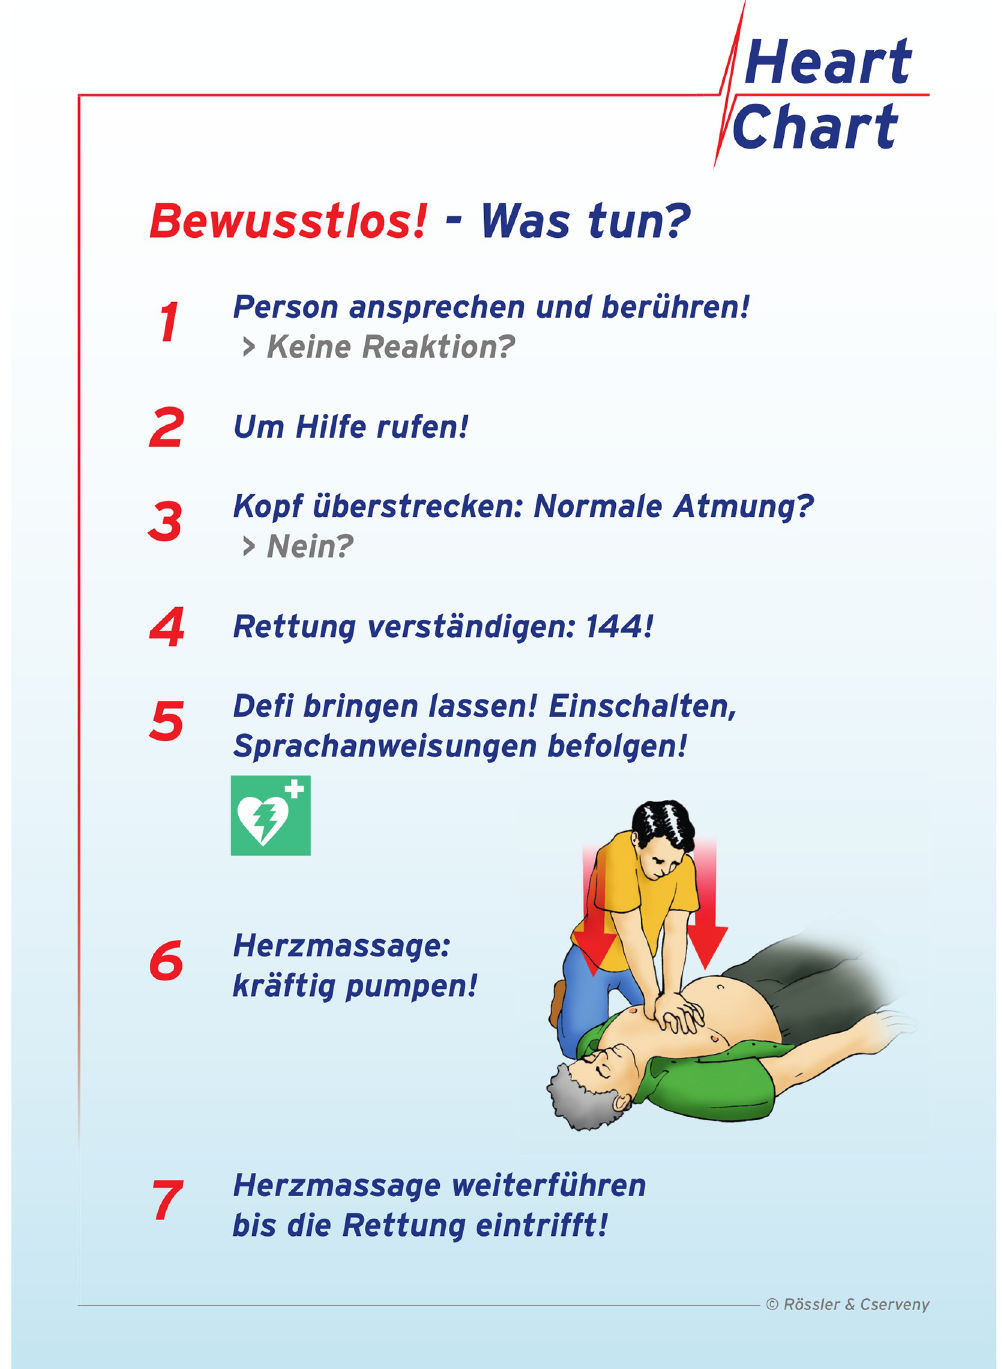
Fig 2. Flowchart of CC-only. Unconscious!—What to do? 1. Speak to and touch the collapsed person! No reaction? 2. Shout for help! 3. Open airway: Breathing?—No? 4. Dial emergency medical service: 144! 5. Send for an Automated External Defibrillator: Activate and follow voice instructions! 6. Chest compressions: Push hard in the middle of the chest. Continue until emergency medical service arrives.